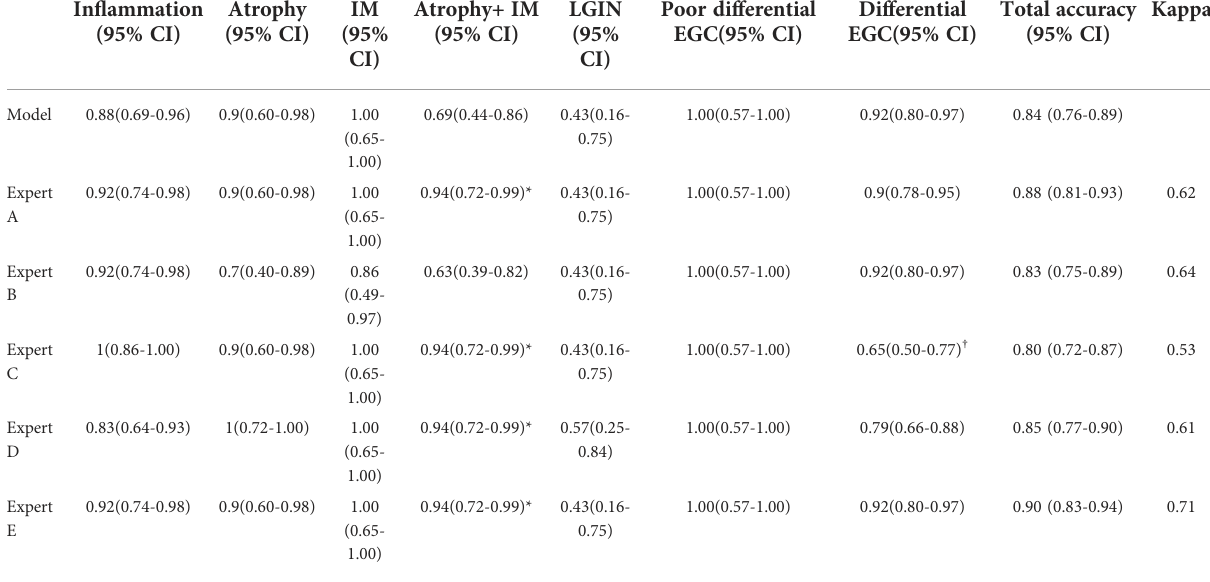
TABLE 4 Diagnostic accuracy of the model versus experts.